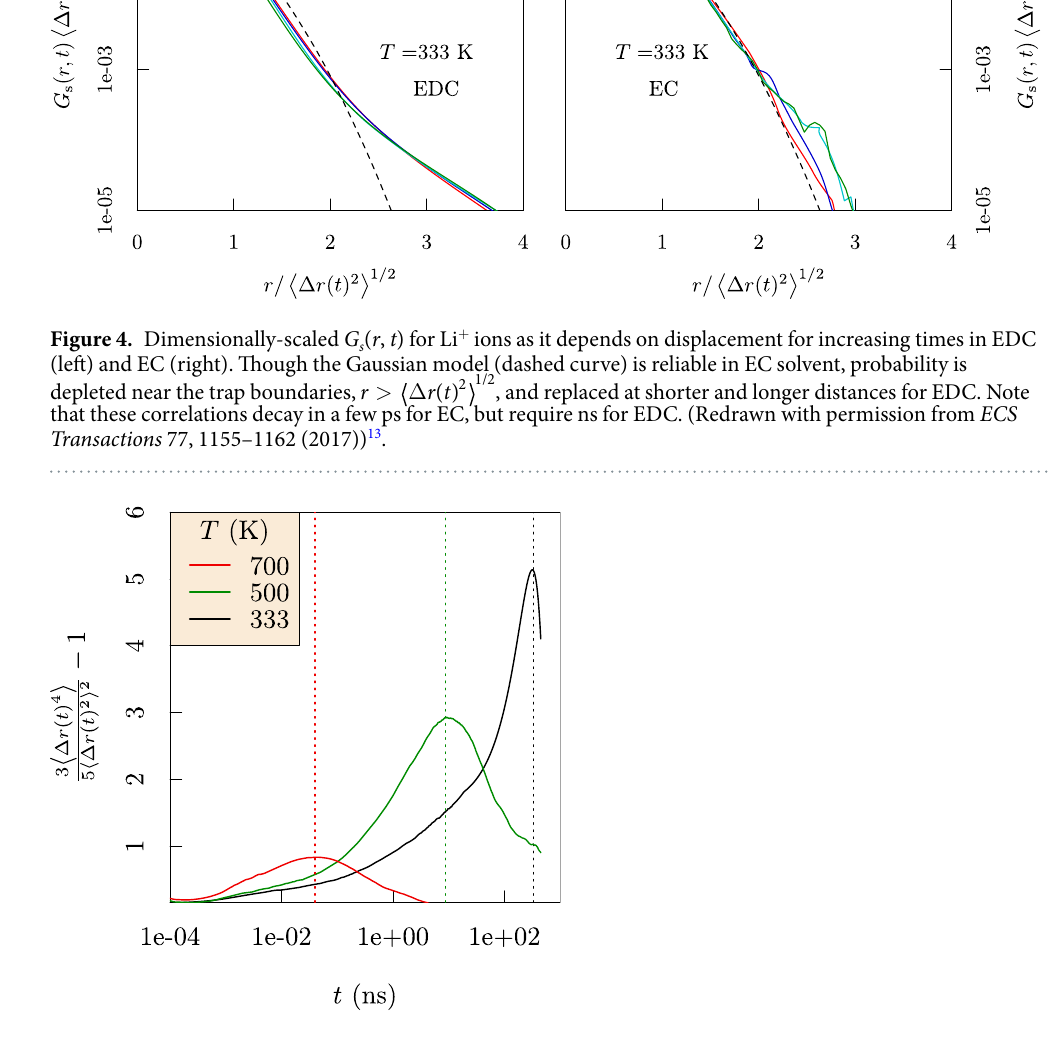
Figure 5. Non-Gaussian parameter calculated for Li + in EDC at several temperatures. Vertical lines are drawn at the maximum value of α ( t ). The non-zero value and inverse temperature dependence of α ( t ) attests to the glassy behavior of EDC, which becomes more fluid-like at higher